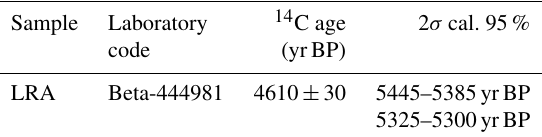
Table 1. Results of the radiocarbon dating performed by the Beta Analytic Radiocarbon Dating Laboratory (Florida, USA) on the wood fragment buried within the Lettopalena rock